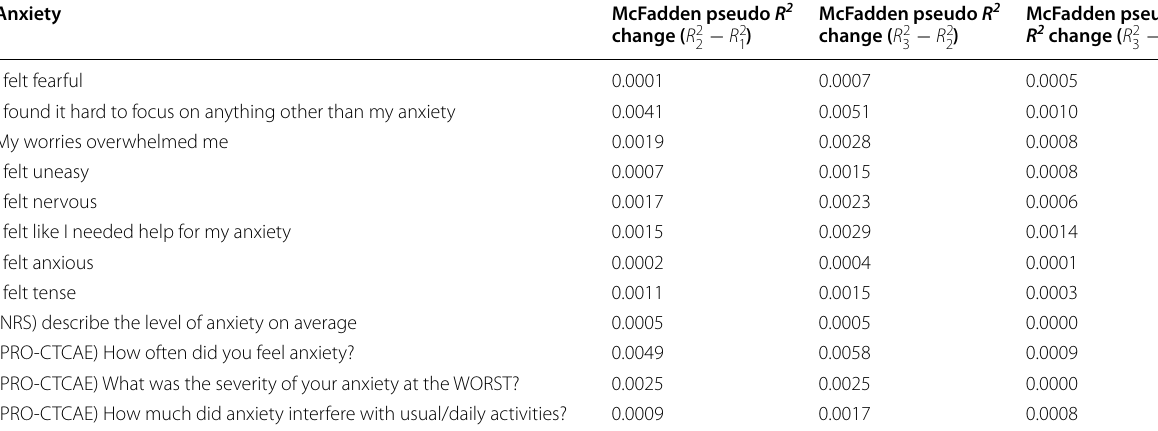
A base model (model 1) posits that only the trait level predicts responses. A second model (model 2) has both trait level and group as independent variables. If model 2 predicts item responses statistically significantly better than model 1 (i.e., McFadden pseudo R 2 change ( R 2 2 − R 2 1 ) 0.02), then there is uniform DIF. In uniform DIF, ≥ DIF has a consistent impact across trait levels. If the model that includes an interaction term between trait and group (model 3) fits significantly better than model 2 (i.e., McFadden pseudo R 2 change ( R 2 3 − R 2 2 ) 0.02), then the impact of DIF varies by trait level (nonuniform DIF). If model 3 fits significantly better than model 1 (i.e., ≥ McFadden pseudo R 2 change ( R 2 3 − R 2 1